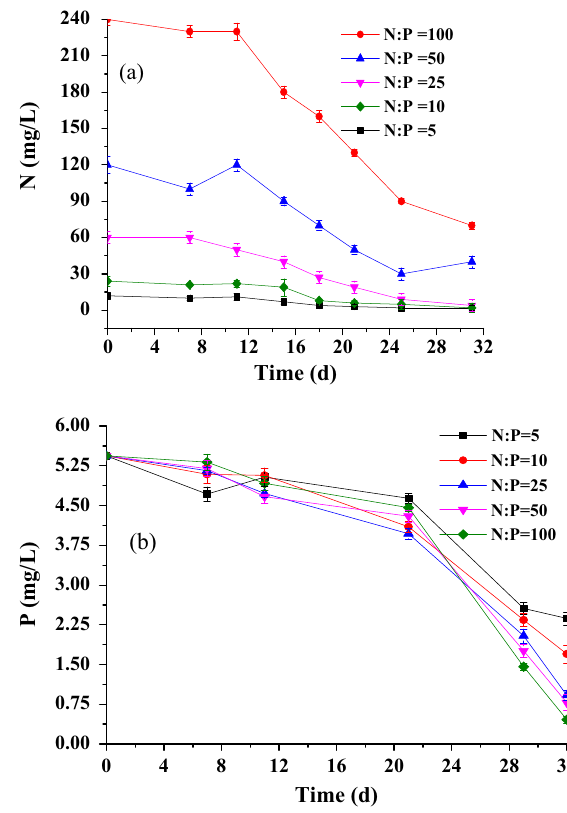
Figure 2: The variation of ( a ) N concentrations and ( b ) phosphate concentrations in medium consisting of di ff erent N:P ratios with time.